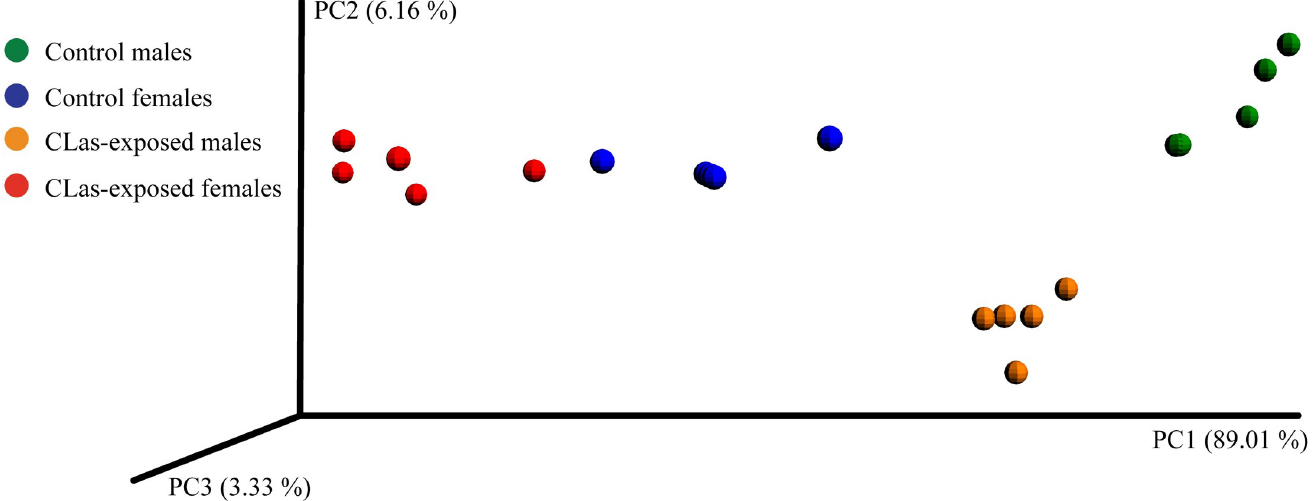
Fig 3. Principal coordinates analysis of weighted UniFrac distances between D . citri microbial communities based on 16S rRNA gene sequences. Microbial communities of CLas-exposed males are depicted in orange, CLas-exposed females are depicted in red, control males are depicted in green, and control females are depicted in blue.